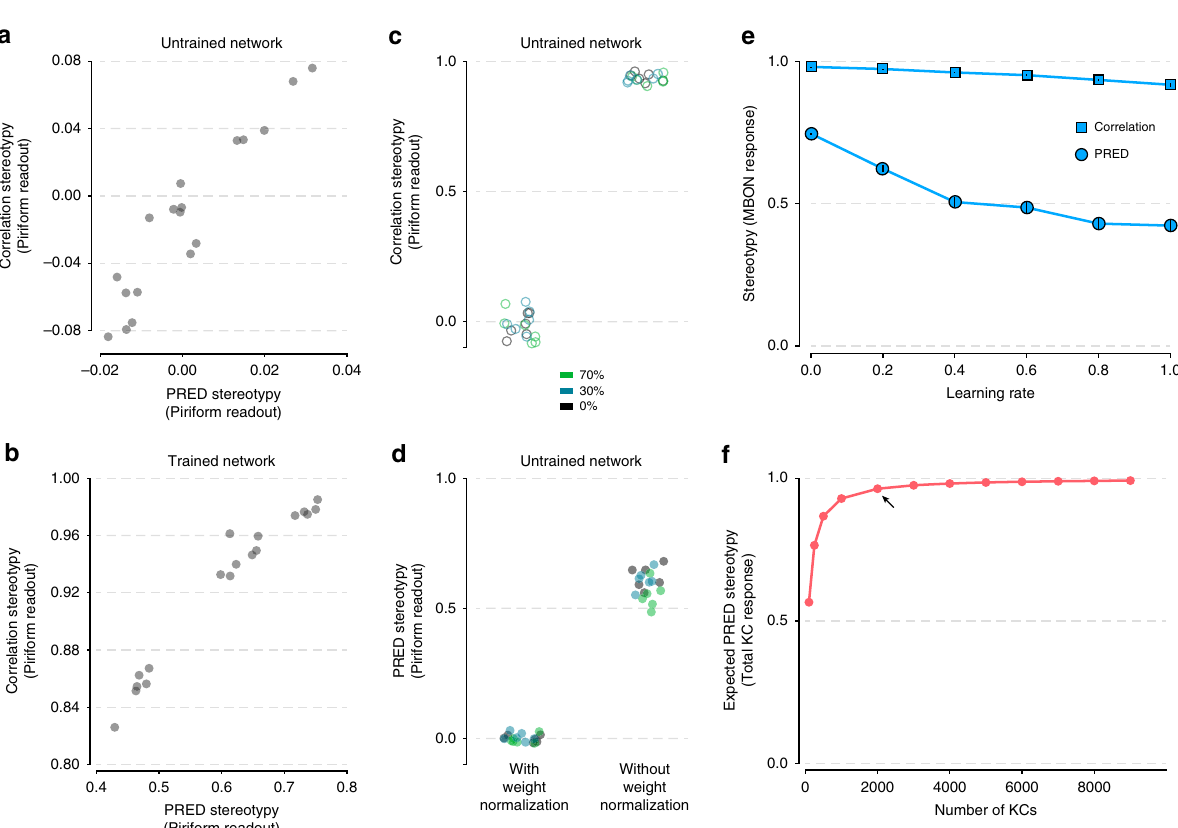
group, including values calculated for pairs of odors at different concentrations (that is, with one odor in the pair at 0.1% and the other at 10%). The across-concentration group is expected to in a pair, and therefore more stereotypy. The experimental data con fi rmed this prediction: the within-concentration group had a stereotypy of 0.17 which was signi fi cantly less than 0.34 seen in the across-concentration group ( P = 2.20 × 10 − 03 , unpaired t -test; Fig. 4d).